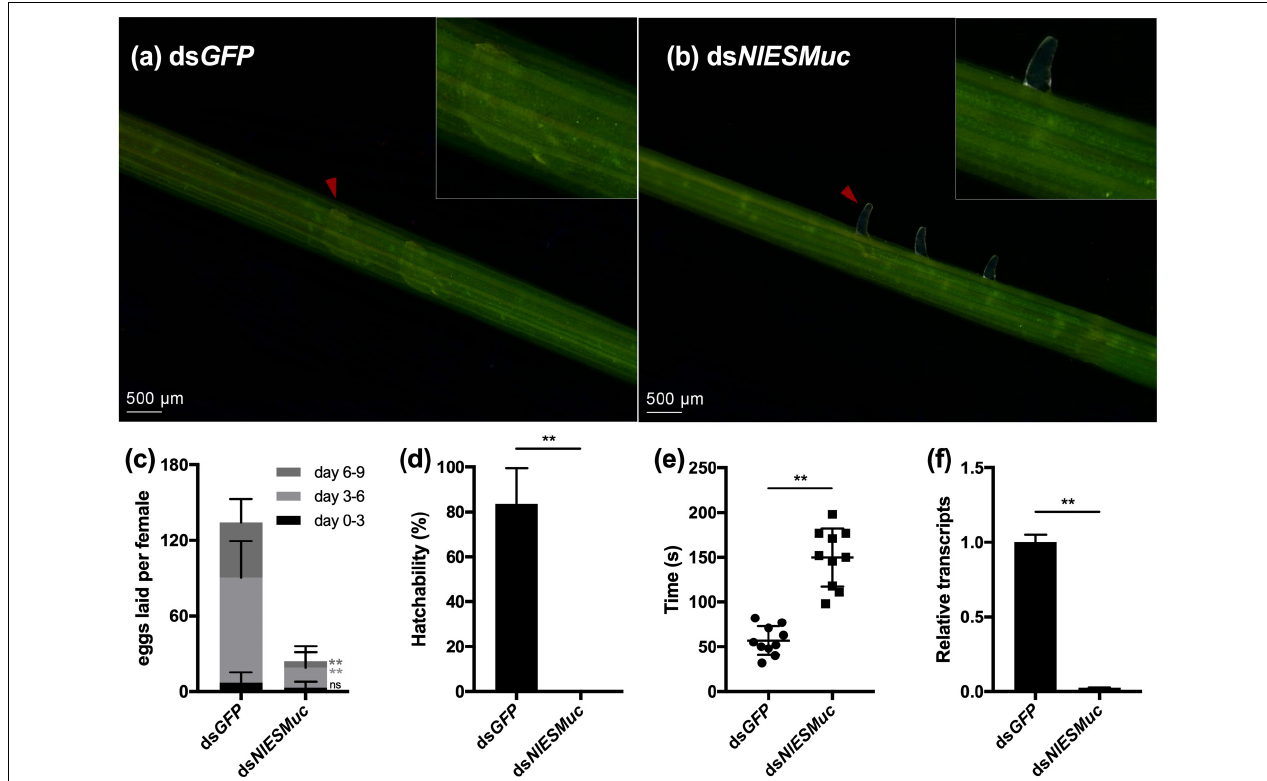
FIGURE 3 | The effect of RNAi on oviposition in dsGFP (control) and ds NlESMuc groups. (a,b) The eggs laid in rice seedlings; the upper right corner shows an enlarged image. Arrowheads indicate the eggs laid in both groups. The ds NlESMuc eggs were partially inside the rice tissue, leaving the anterior half and micropyle area exposed. (c) The average number of eggs laid per female in both groups. The dsNlESMuc females had significantly reduced fecundity. (d) The hatchability in both groups. The hatchability in ds NlESMuc group was significantly affected when compared to that in dsGFP group. (e) The duration from ovipositor penetration to withdrawal. The process was longer after NlESMuc knockdown. (f) RNAi efficiency. Not significant (ns) P ≥ 0.05, ∗∗ P ≤